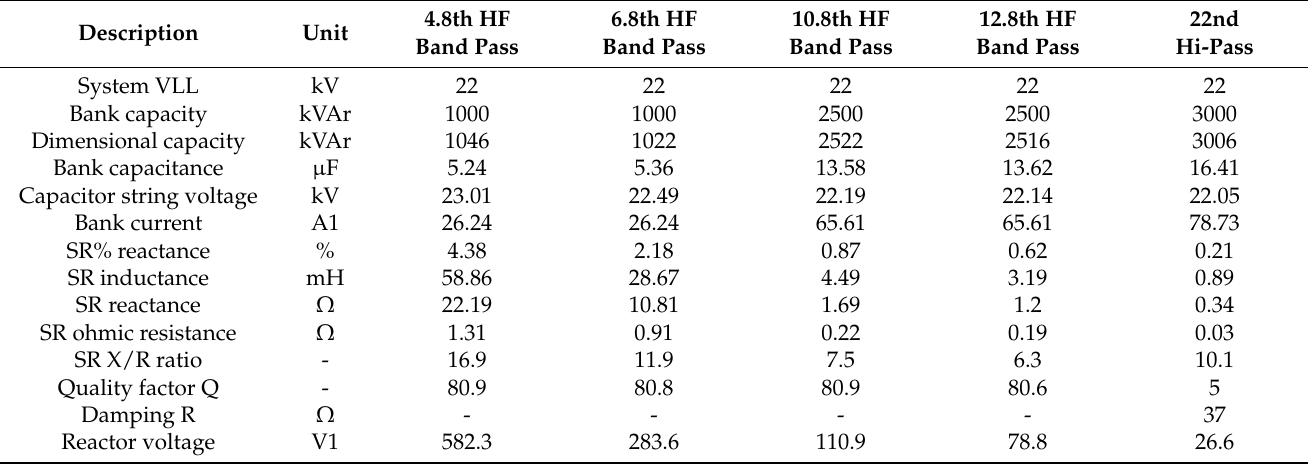
Table 4. Harmonic filter design parameters.